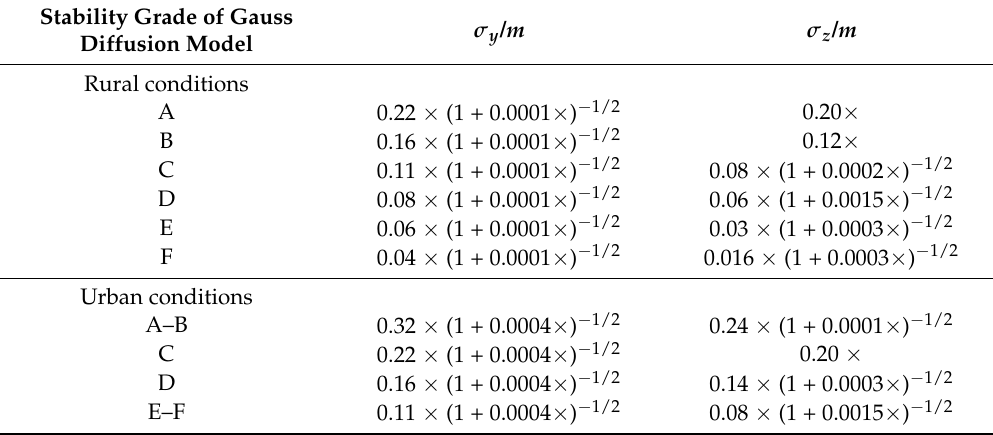
Table 1. Diffusion coefficient equation of the Gauss diffusion